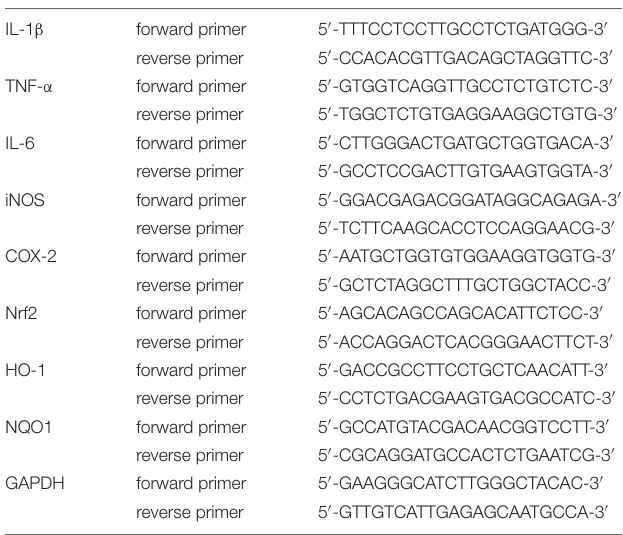
TABLE 1 | Sequences of oligonucleotide